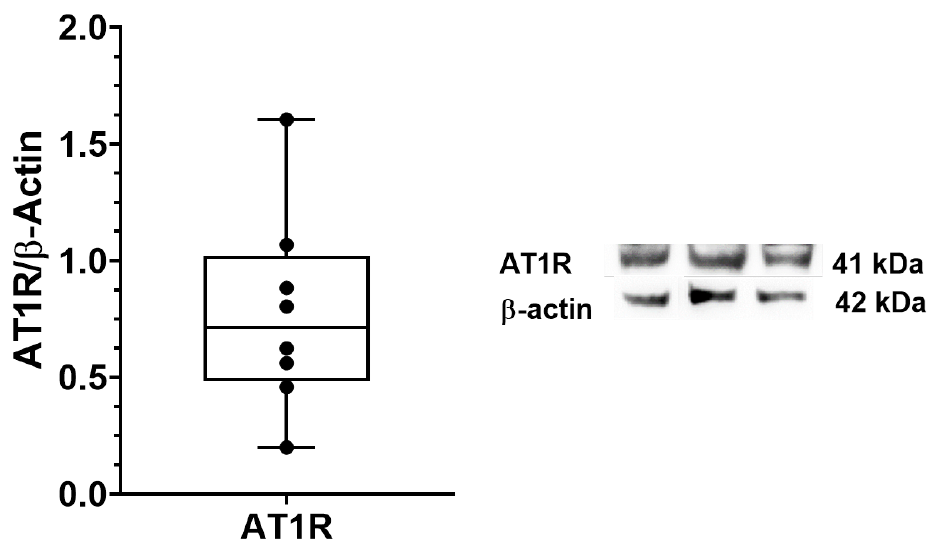
Figure 5. AT1R protein expression in human thoracolumbar fascia. Immunoblotting of AT1R protein in TLF (n = 8). Relative quantitation of AT1R vs. β -actin expression is shown in the bar graph.